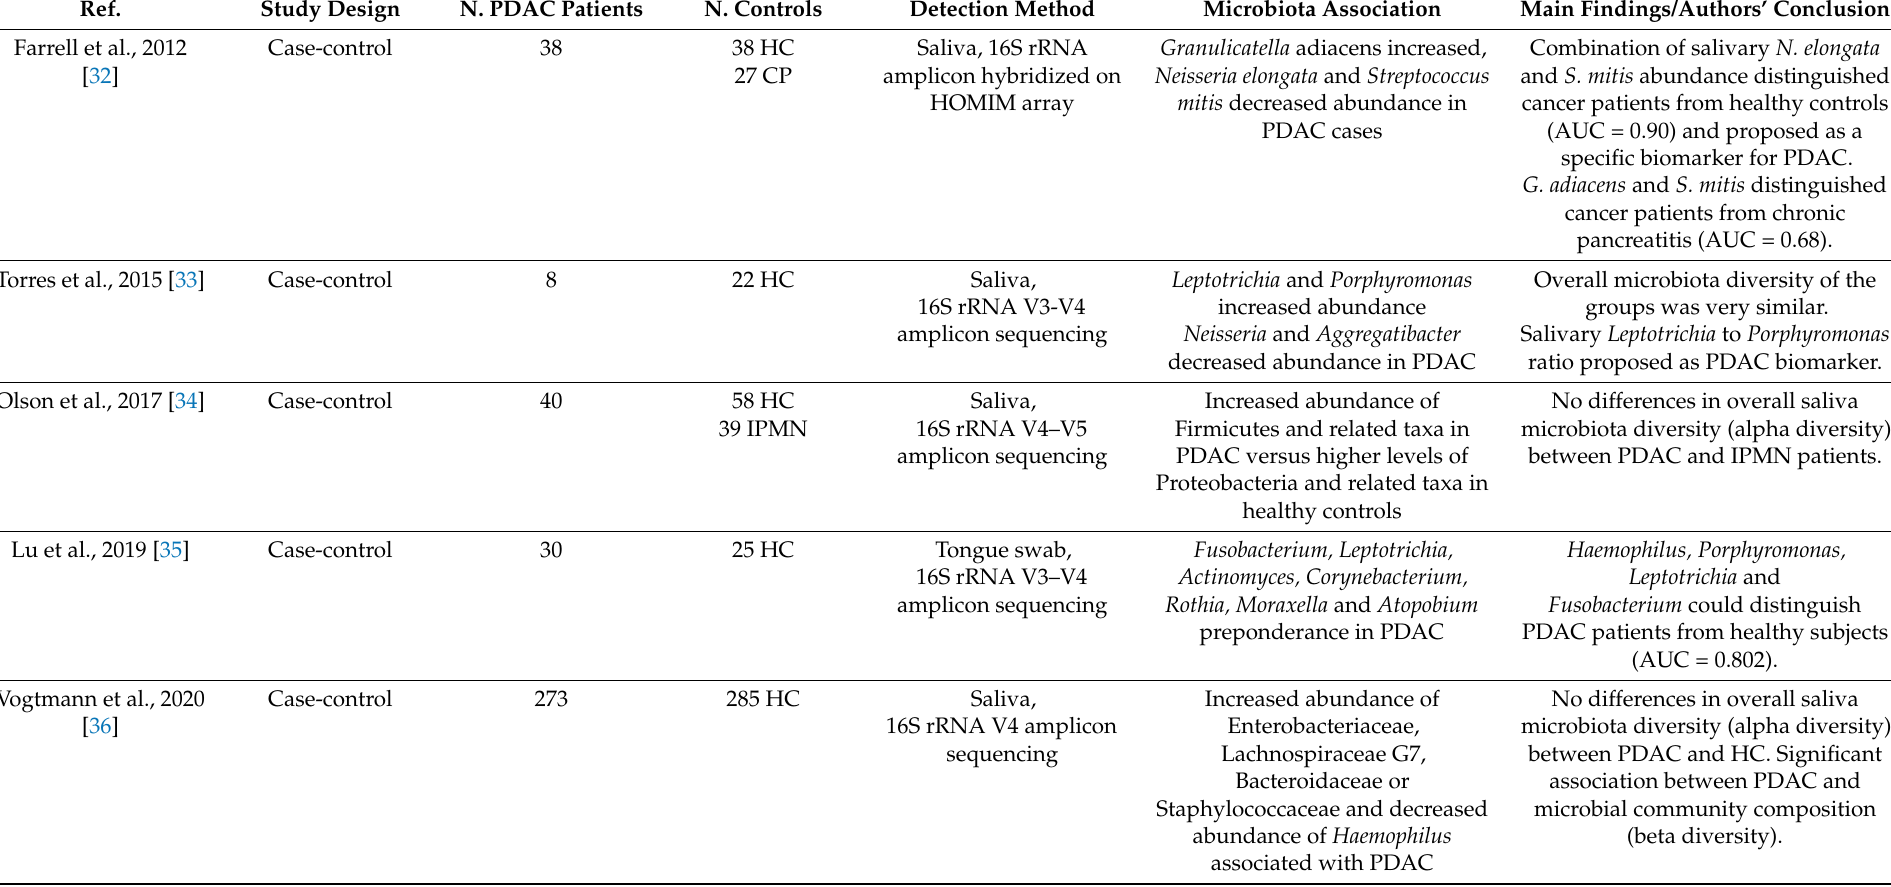
Table 1. List of studies investigating the correlation between oral microbiota alterations and pancreatic ductal adenocarcinoma (PDAC). Pancreatic ductal adenocarcinoma (PDAC); number of subjects (N); healthy control (HC); chronic pancreatitis (CP); intraductal papillary mucinous neoplasm (IPMN); Human Oral Microbe Identification Microarray (HOMIM); the area under the parasitemia curve